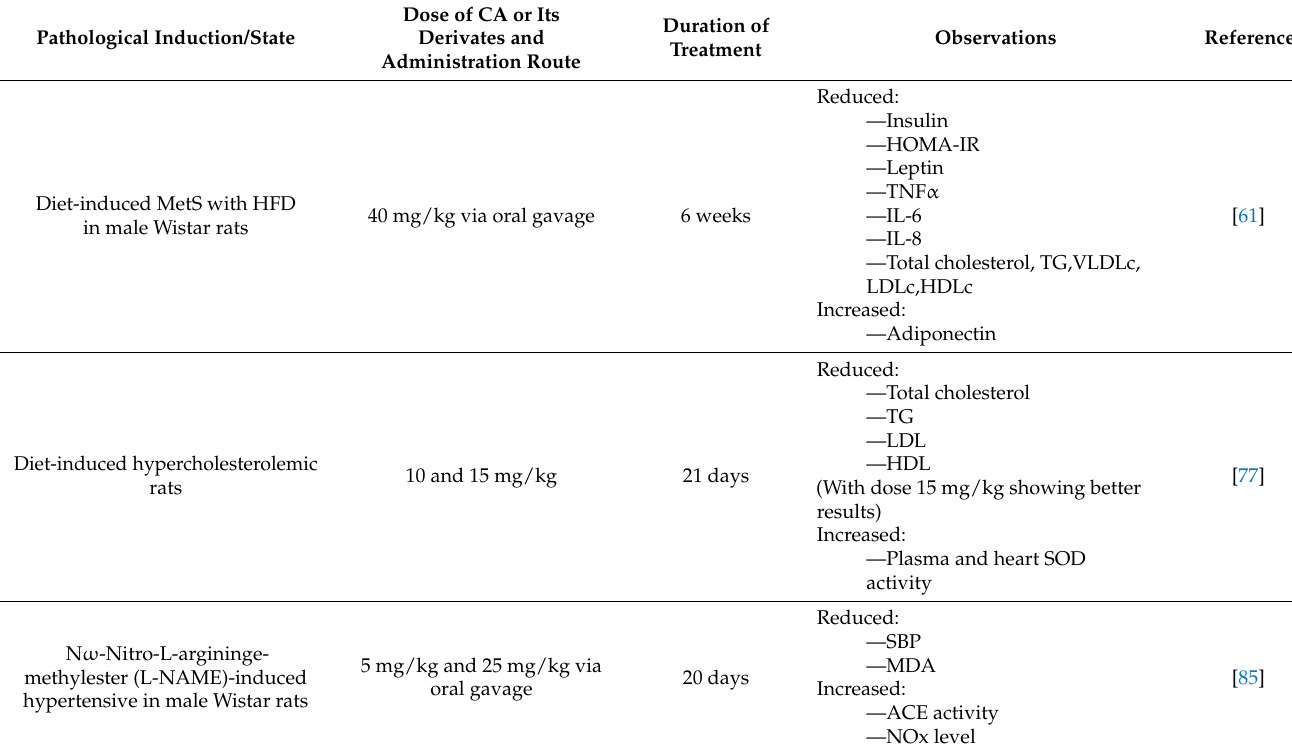
Table 1. MetS studies related to